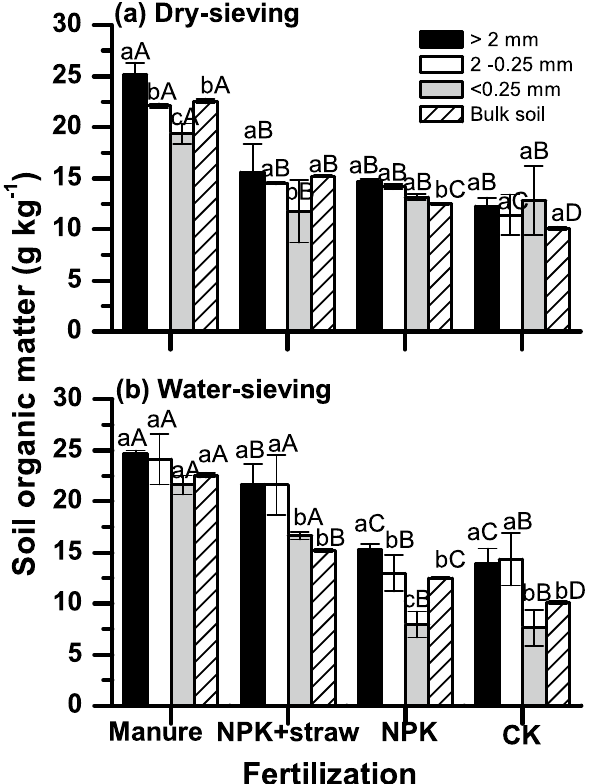
Figure 1. Soil organic matter (SOM) distribution on different aggregate size across treatments at ( a ) dry sieving and ( b ) water sieving. Different lower-case letters indicate significant differences of SOM among aggregate size under the same of fertilization. Different capitalized letters indicate significant differences of SOM among the four types of fertilization at the same aggregate